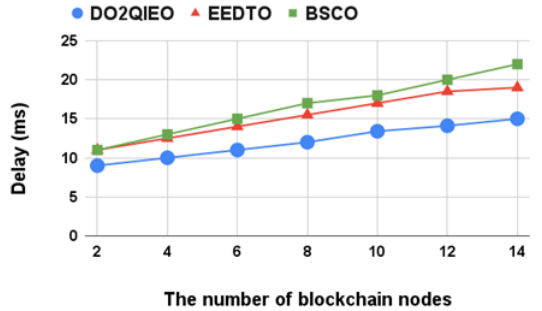
Figure 13. System latency in comparison to different blockchain nodes.